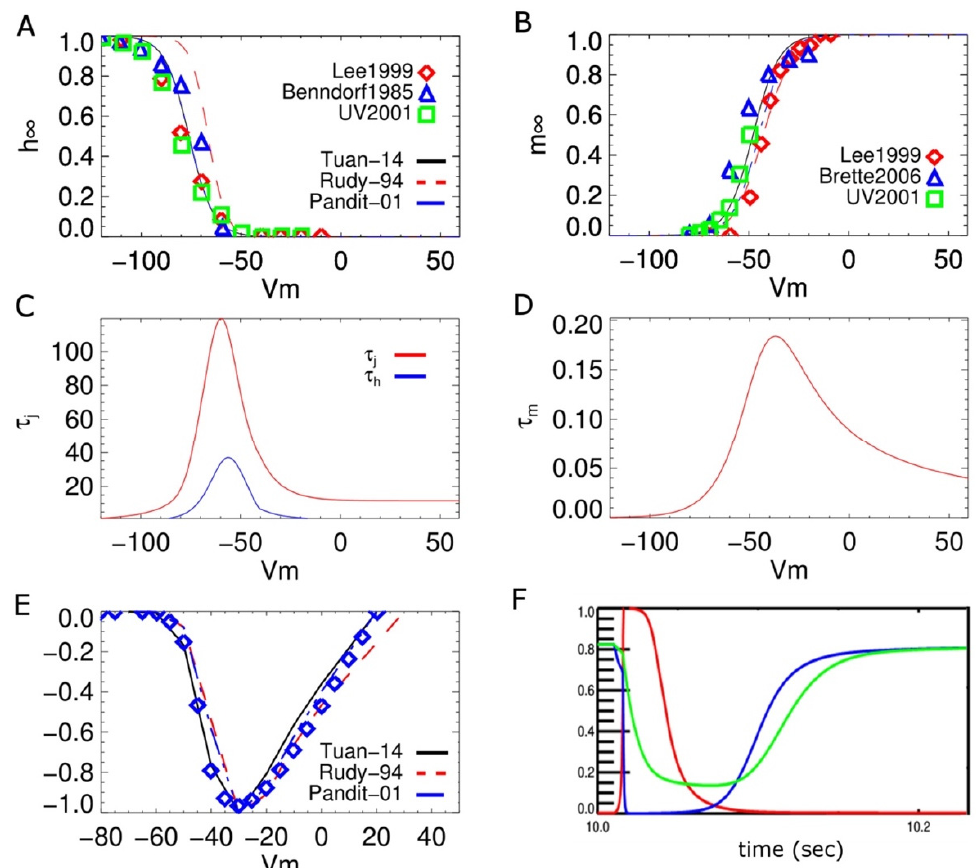
Figure 3. ( A ) steady-state inactivation curve ( B ) steady-state activation curve; ( C ) voltage dependence of slow inactivation gate time constant ( D ) voltage dependence of activation gate time constants at different voltages. ( E ) I-V curve, ( F ) dynamics of gating variables of the proposed model during an AP—activation gate m (red), inactivation gate h (blue), and slow inactivation gate j